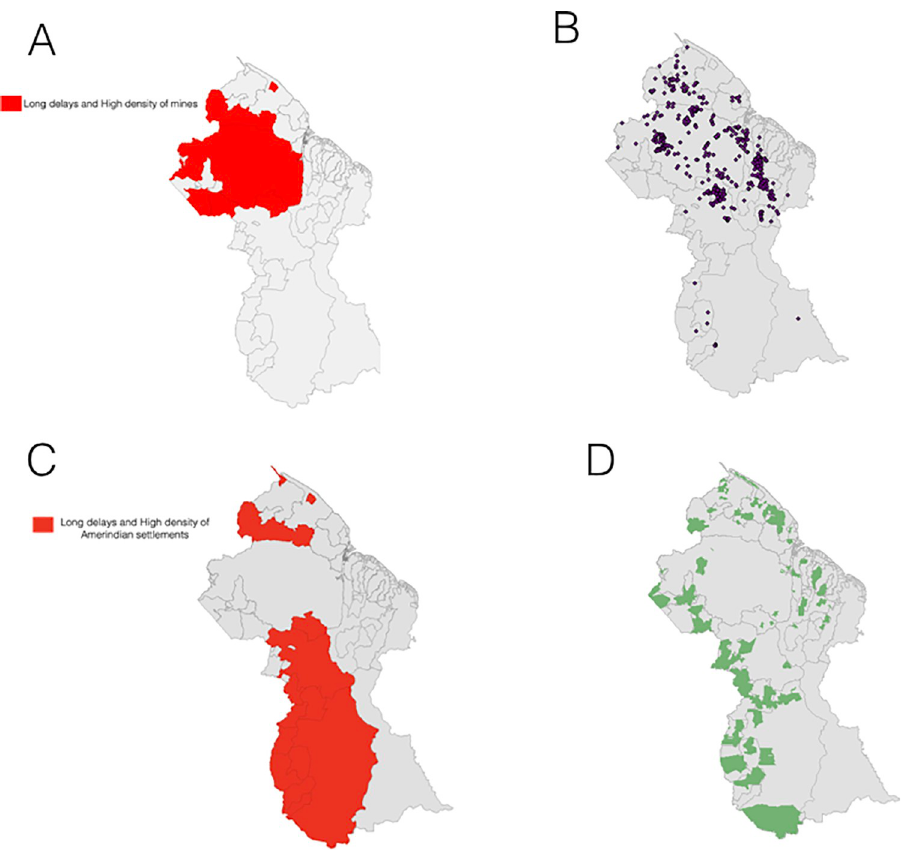
Fig 2. A. Local bivariate Moran’s I clustering map of aggregated delays and density of mines, by NDC; B. Map of mining sites; C. Local bivariate Moran’s I clustering map of aggregated delays and density of Amerindian settlements, by NDC; D. Map of Amerindian areas. For visual purposes, we show only high-high clusters of areas reporting at higher delays with a greater density of mines or Amerindian settlements. Full bivariate cluster and significance maps can be found in S5 Fig. Base map sourced from DIVA-GIS